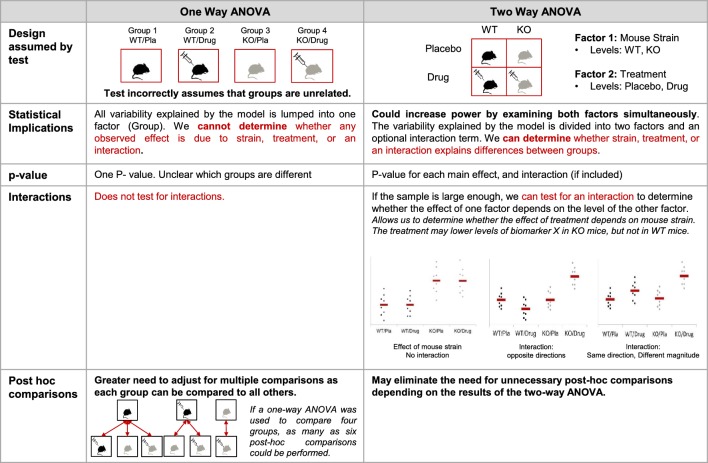
Additional implications of using a one-way vs two-way ANOVA.This figure compares key features of one- and two-way ANOVAs to illustrate potential problems with using a one-way ANOVA for a design with two or more factors. When used for a study with two factors, the one-way ANOVA incorrectly assumes that the groups are unrelated, generates a single p-value that does not provide information about which groups are different, and does not test for interactions. The two-way ANOVA correctly interprets the study design, which can increase power. The two-way ANOVA also allows for the generation of a set of p-values that provide more information about which groups may be different, can test for interactions, and may eliminate the need for unnecessary post-hoc comparisons. This figure uses an experimental design with four groups (wild-type mice receiving placebo, wild-type mice receiving an experimental drug, knockout mice receiving placebo and knockout mice receiving an experimental drug). See Figure 2 for a detailed explanation of the material in the statistical implications section. KO: knockout; WT: wild-type; Pla: placebo.